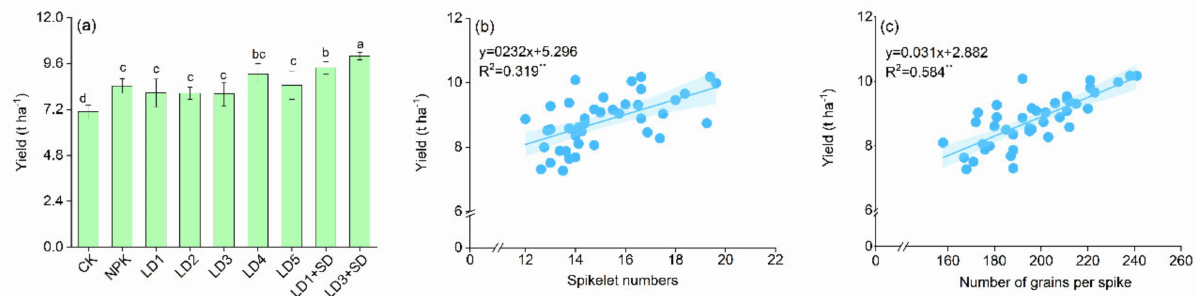
Figure 5. Rice yield ( a ) and the relationships between spikelet numbers ( b ), number of grains per spike ( c ), and rice yield, respectively. The values are means with standard error bars. Different letters above the bars indicate significant differences at the 5% level.